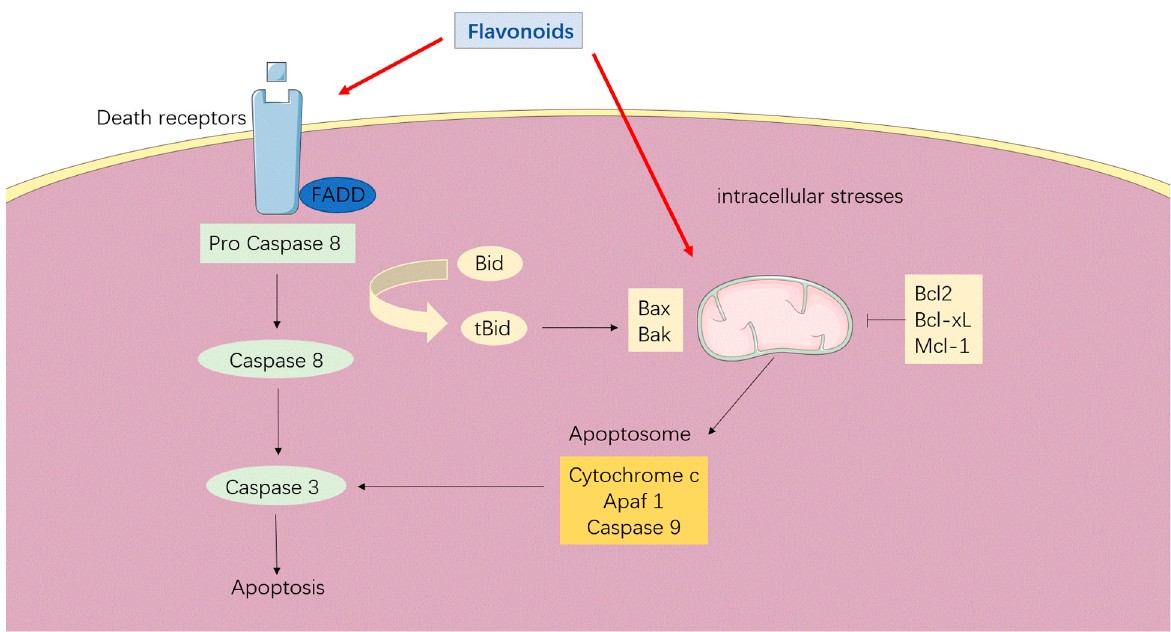
Figure 4. Flavonoids promote intrinsic and extrinsic apoptosis pathways. Two principal pathways are involved in cell apoptosis. The intrinsic pathway is triggered by diverse intracellular stresses, which activate cytochrome c, Apaf-1, and caspase-9 to form an apoptosome through regulation of BH3-only and Bcl2-like proteins and promote apoptosis. The extrinsic pathway induced when the TNF family binds to death receptors on the cell surface, which activates caspase-8 and caspase-3 through Fas-associated death domain protein (FADD) and provokes cellular destruction. Flavonoids induce cell apoptosis via intrinsic and extrinsic pathways.